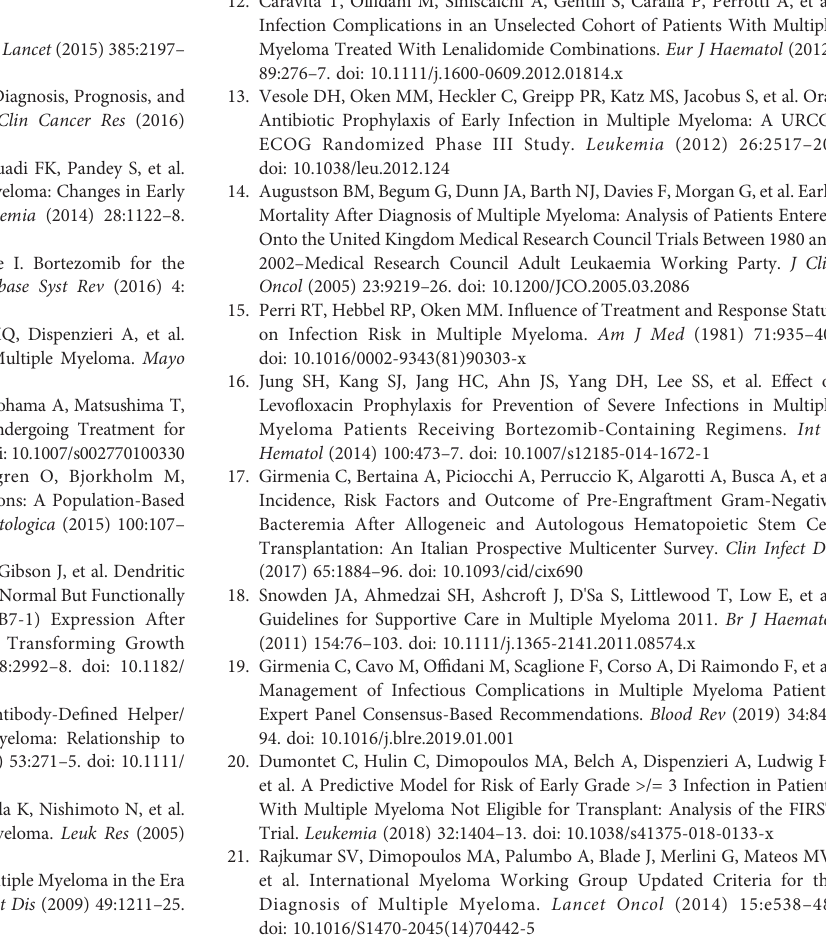
Supplementary Table S1 | Microbiology of infections during the fi rst 3 months and entire